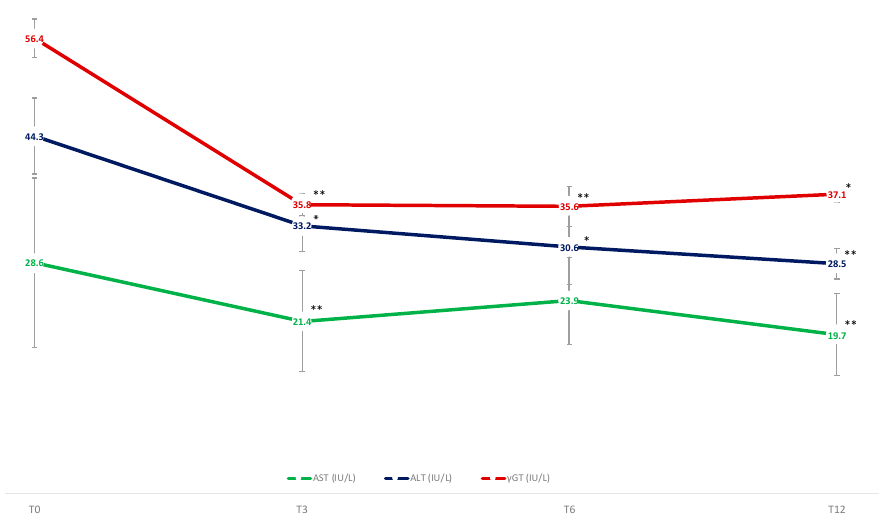
Figure 7. Mean changes in serum values of AST, ALT, and γ GT (U/L) over the study period. Means are reported as least squared means estimated by mixed model analysis. Variation versus T0: * p < 0.05; ** p < 0.01. Abbreviations AST: ASpartate aminoTransferase; ALT: ALanine aminoTransferase; γ GT: gamma-glutamyl transferase.